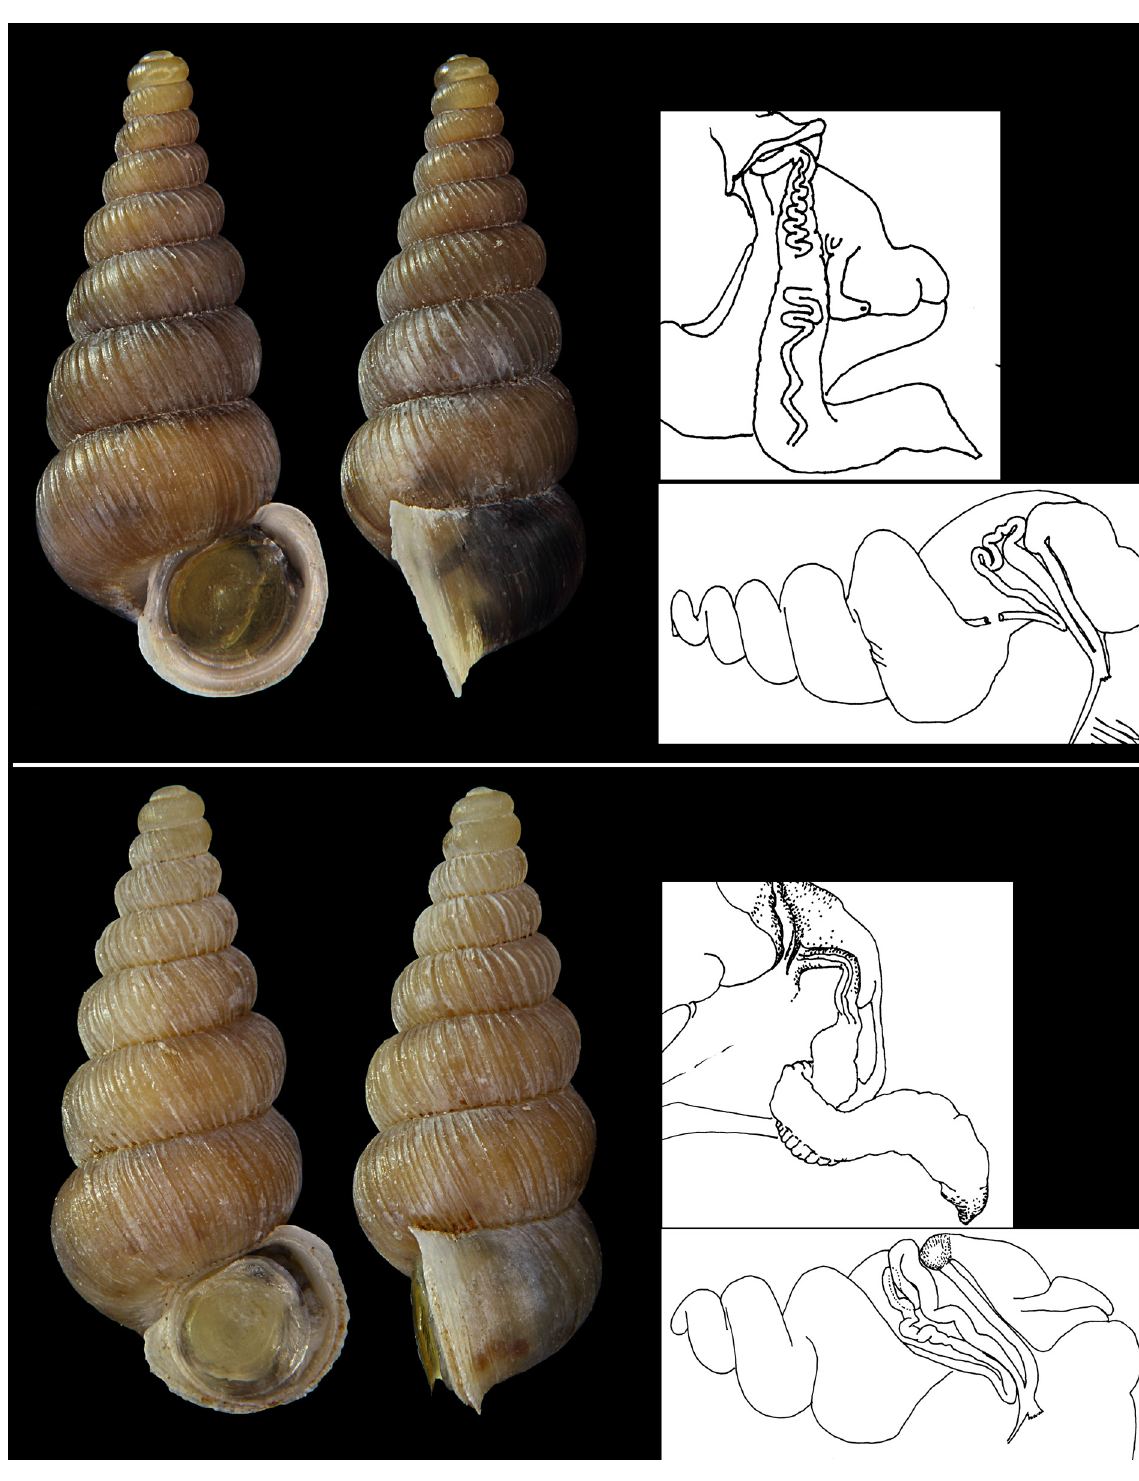
Fig. 34. Example of two populations of species of Clessiniella Zallot et al ., 2015 which are impossible to distinguish without analyzing the male genitalia. Female shells. Top: Cochlostoma ( Clessiniella ) waldemari (A.J. Wagner, 1897), Polog-E of Čepovan, Slovenia (WdM6842). Bottom: Co. ( Cl. ) tergestinum (Westerlund, 1878), Jakačici, Croatia